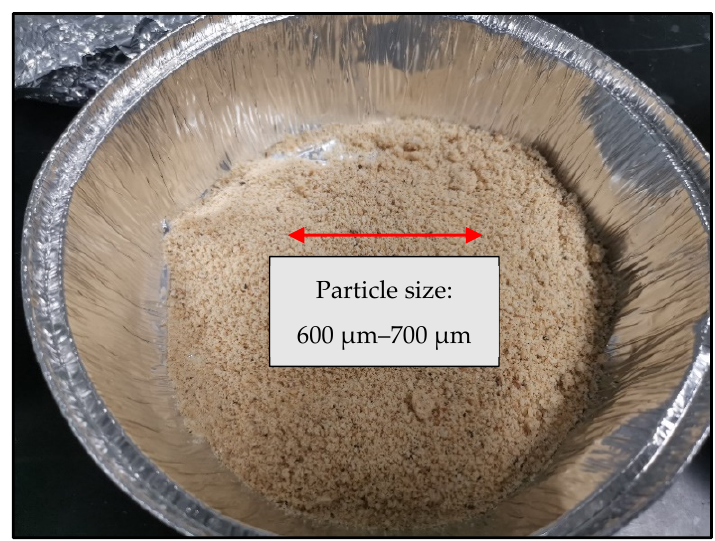
Figure 2. Powdered Jatropha seed.